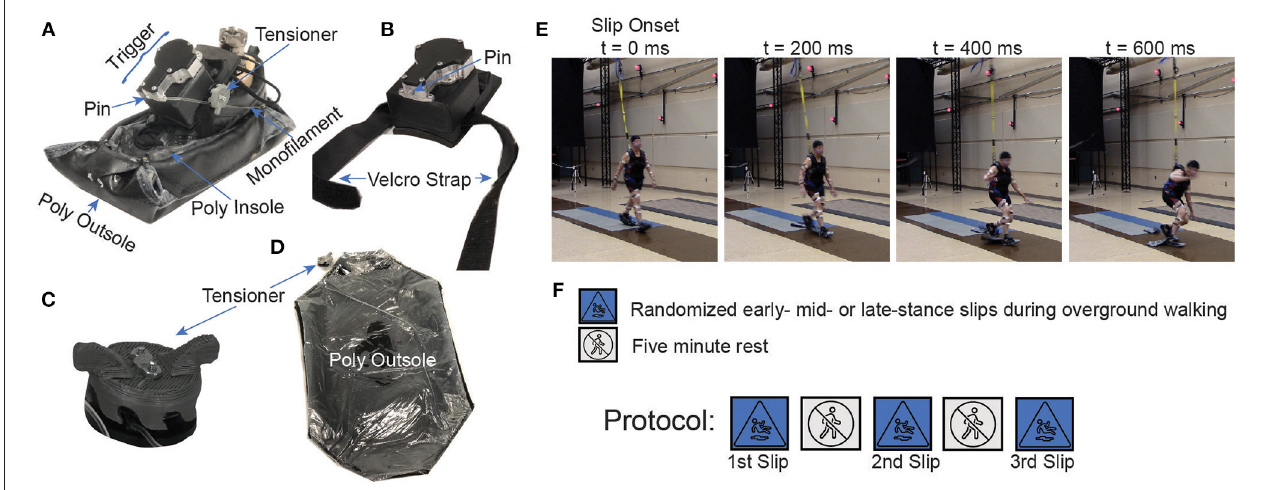
FIGURE 1 | (A) Wearable Apparatus for Slipping Perturbations (WASP) assembly fitted over an athletic shoe worn over a prosthetic foot. (B) The WASP trigger device that was custom built in-lab using metal additive manufacturing; the WASP uses a pin and follower mechanism, and when it triggers, the pin draws backward and releases the monofilament holding the outsole, hence detaching the external (outsole) from the internal (insole) soles, causing a rapid decrease in friction. (C) The tensioner adjusts the monofilament tension holding the outsole based on the participant’s shoe size. (D) Outsole consists of a layer of rubber, and a layer of PTFE, (Teflon), coated with WD-40 oil to ensure reduced friction with the insole. (E) Photo sequence shows a representative trial of a bilateral slips administered to the dominant (right foot in this case) limb during early stance, which automatically induces a late stance slip on the non-dominant foot (left). The photos are taken at 200, 400, and 600ms post slip onset. (F) Protocol Outline. Participants completed three randomized unconstrained simultaneous bilateral slips trials of early stance (ES), mid stance (MS), and late stance (LS). Participants rested while seated for 5min between